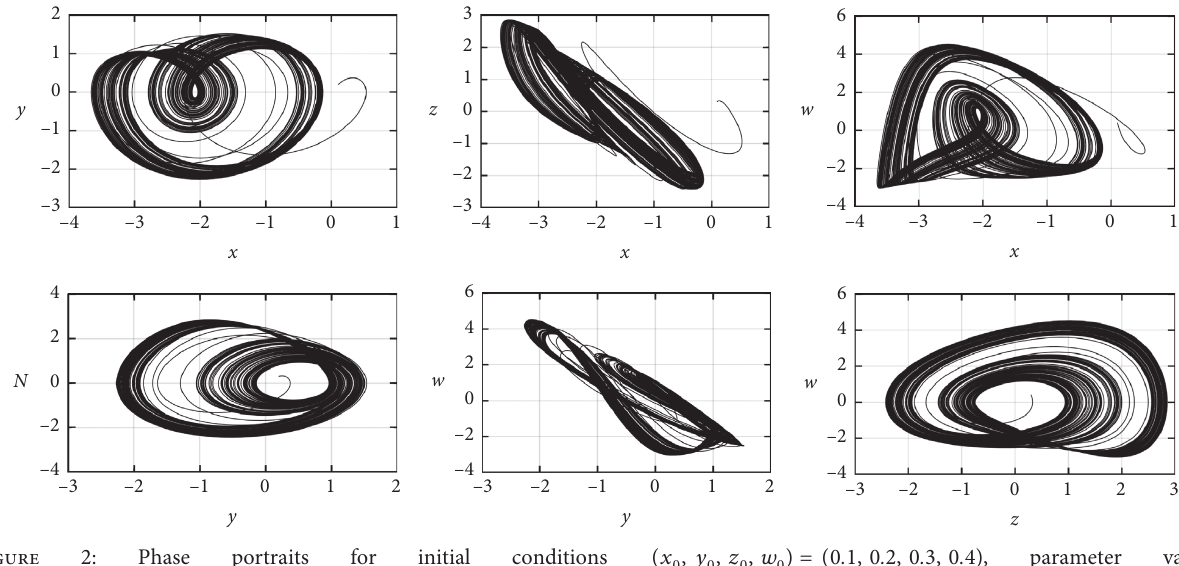
2: Phase portraits for initial